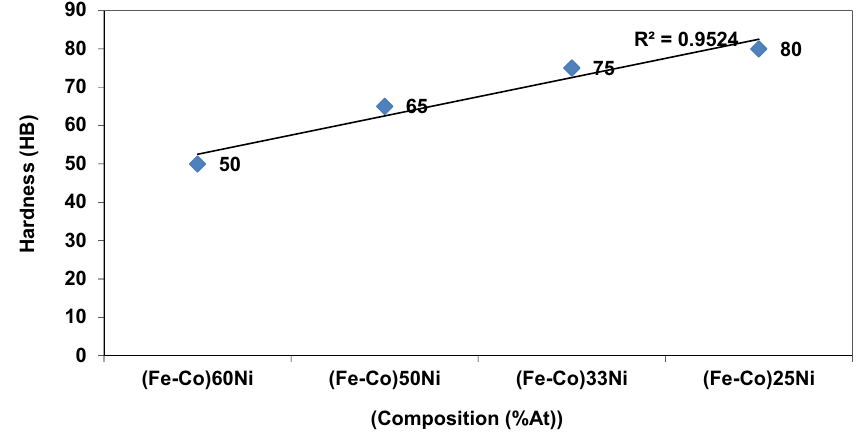
Figure 3: Hardness – composition curve in specimens.